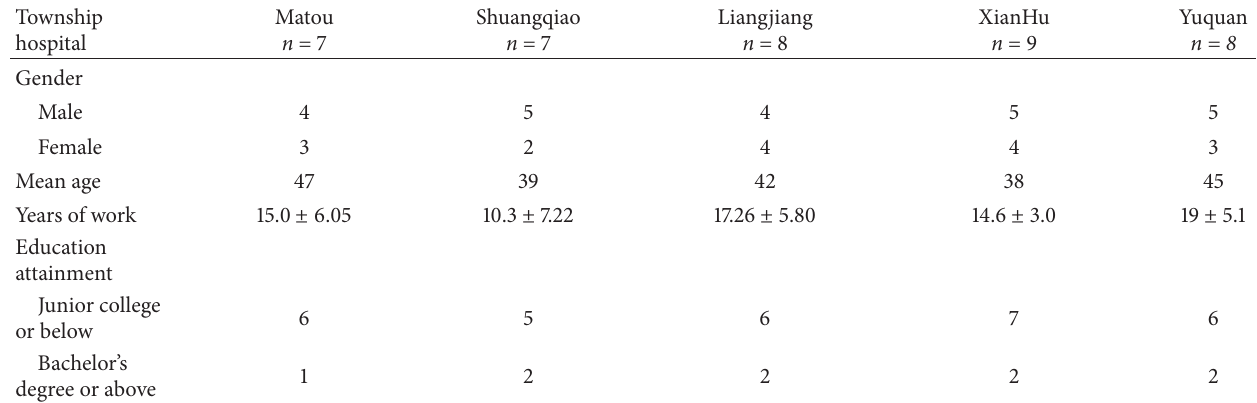
Table 1: Demographic characteristic of FGD participants ( n =